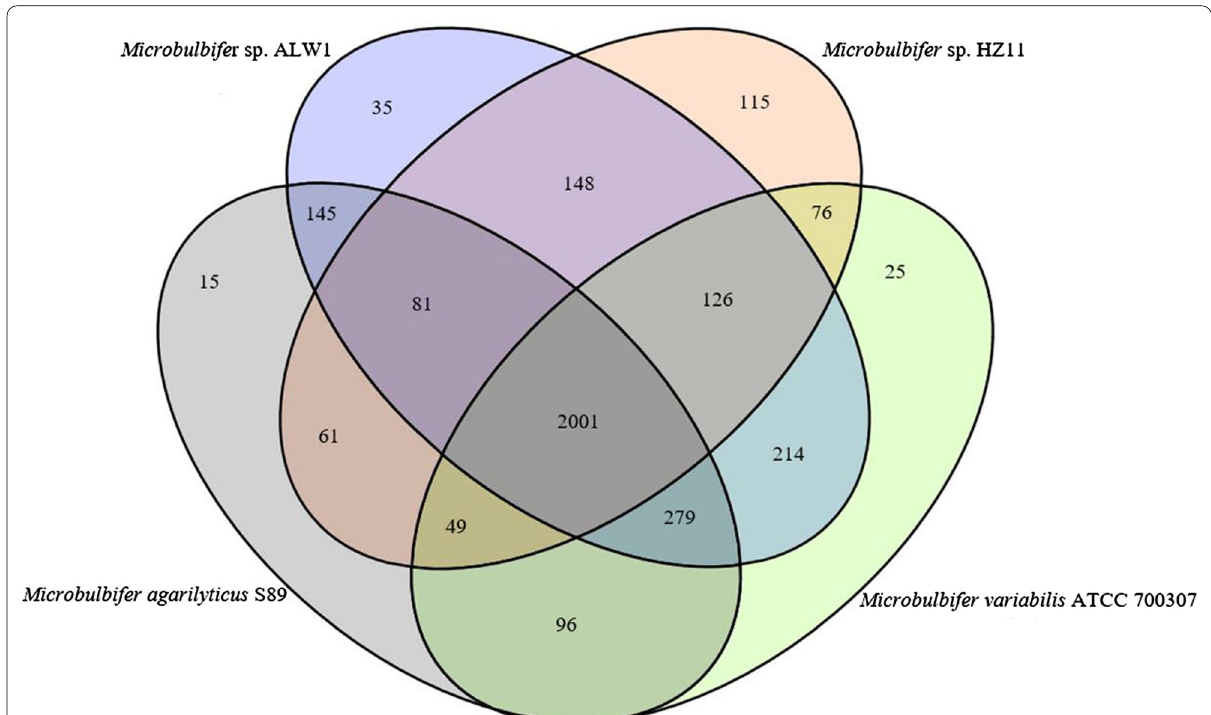
Fig. 5 CAZyme classification of the putative proteins of Microbulbifer sp. ALW1. AA means auxiliary activity. CBM means carbohydrate binding module. CE means carbohydrate esterase. GH means glycoside hydrolases. GT means glycosyltransferases. PL means polysaccharide lyase